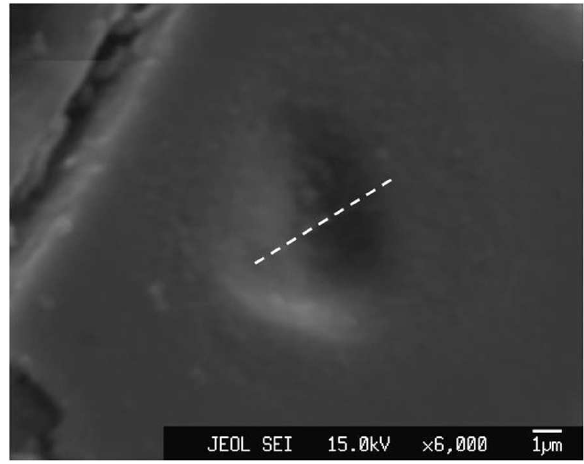
Fig. A1. Secondary electron micrograph of a test section from a Bolivina spissa specimen after measuring with SIMS. The spot di- ameter of the ion beam was about 4–5µm. Data acquisition time was roughly 10min. Estimated depth of the spot ∼ 2µm.